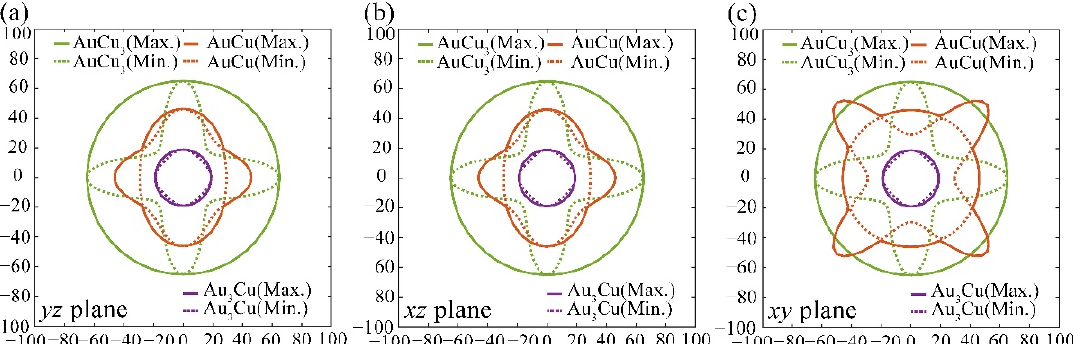
Figure 6. Cross-sections of shear modulus G in the ( a ) yz , ( b ) xz , and ( c ) xy planes for AuCu 3 , AuCu, and Au 3 Cu. Table 6. Anisotropy ratios and maximum and minimum share moduli G for AuCu 3 , AuCu, and Au 3 Cu.